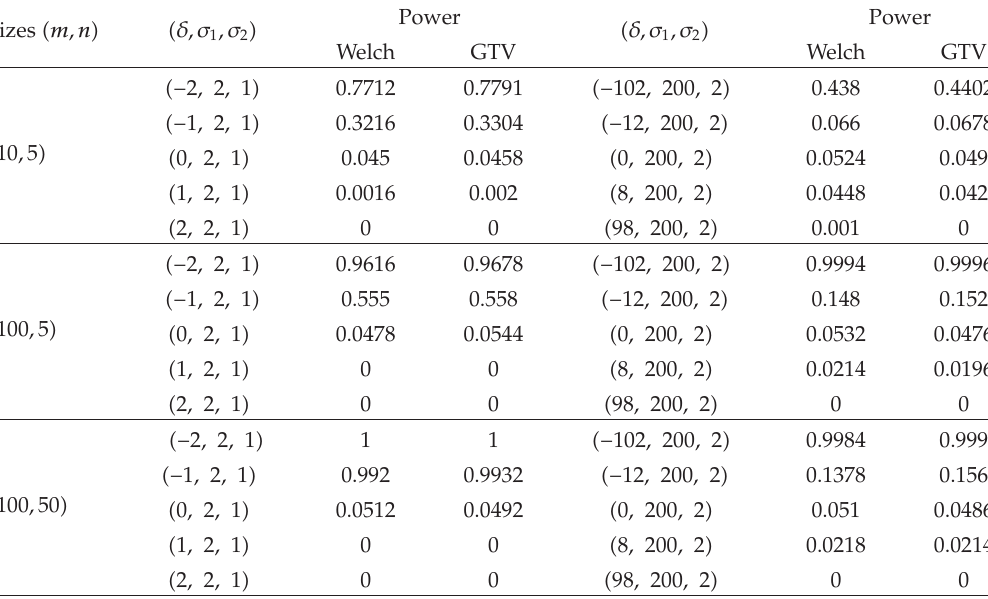
Table 8: Powers for δ for the normal case: other scenarios with unequal sample